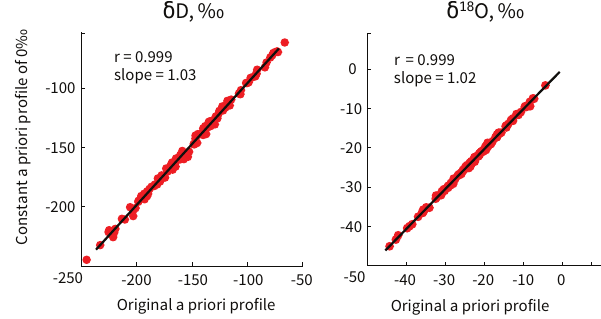
Figure 5. Sensitivity of the retrieval to the shape of a priori profiles of the delta